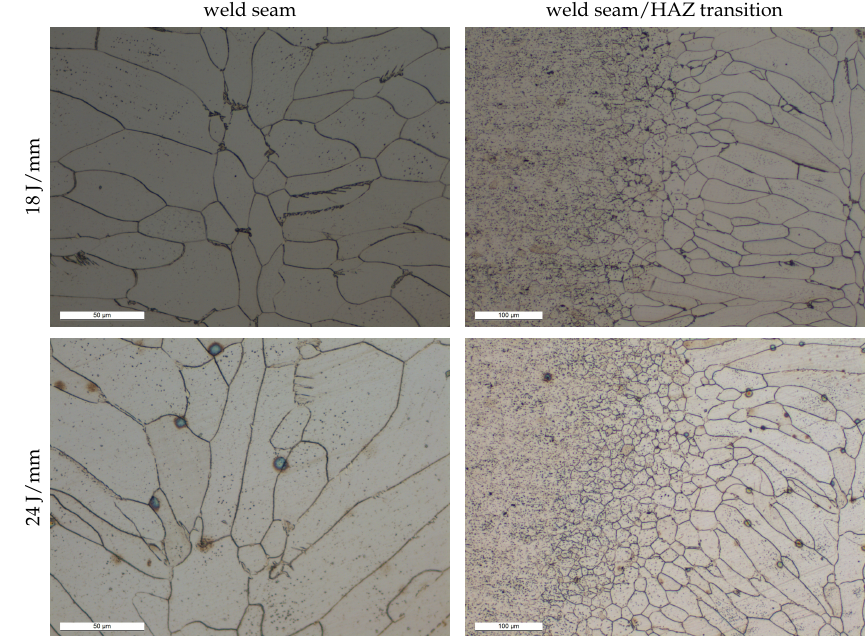
Figure 6. Etched micrographs of AISI430 weld seams obtained at energy inputs of 18 J · mm − 1 and 24 J · mm − 1 . Some sample preparation artifacts are